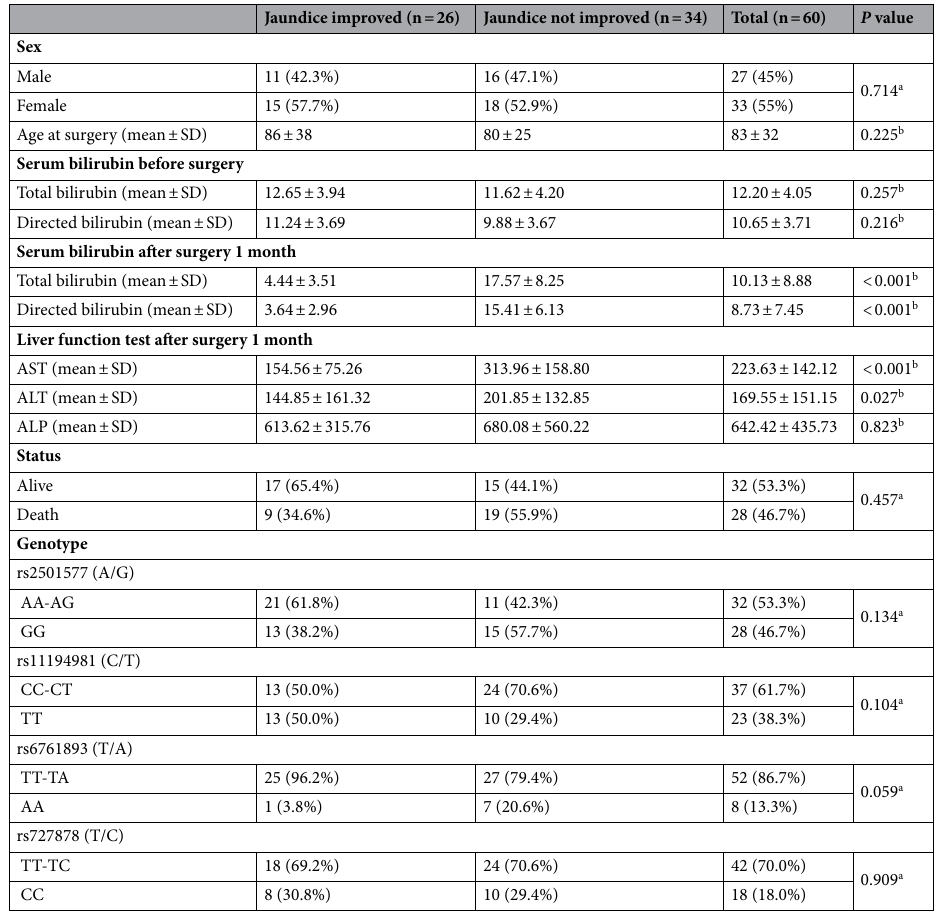
Table 1. Clinical demographic data and genotype information of biliary atresia patients. SD standard deviation, AST serum aspartate transaminase, ALT serum alanine aminotransferase, ALP serum